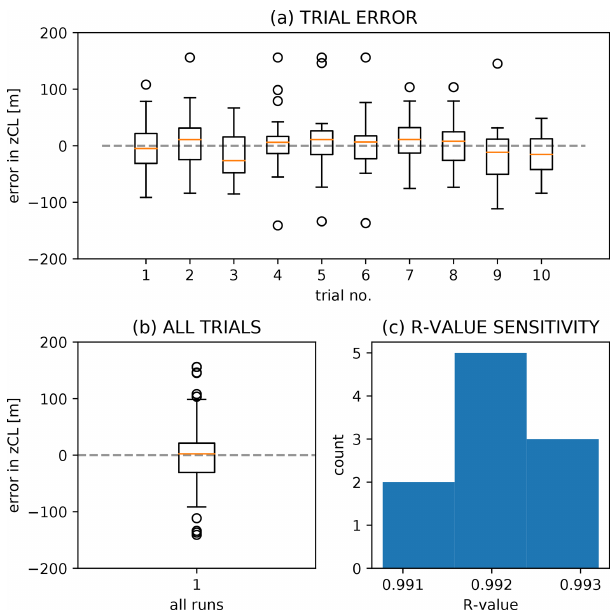
Figure 7. Analysis of model sensitivity to the choice of bias cor- rection parameters. (a) Error distributions for individual trials using independent (test) data. (b) Error distribution for all trials using in- dependent (test) data. (c) Sensitivity of R value (correlation coeffi- cient) for all trials.